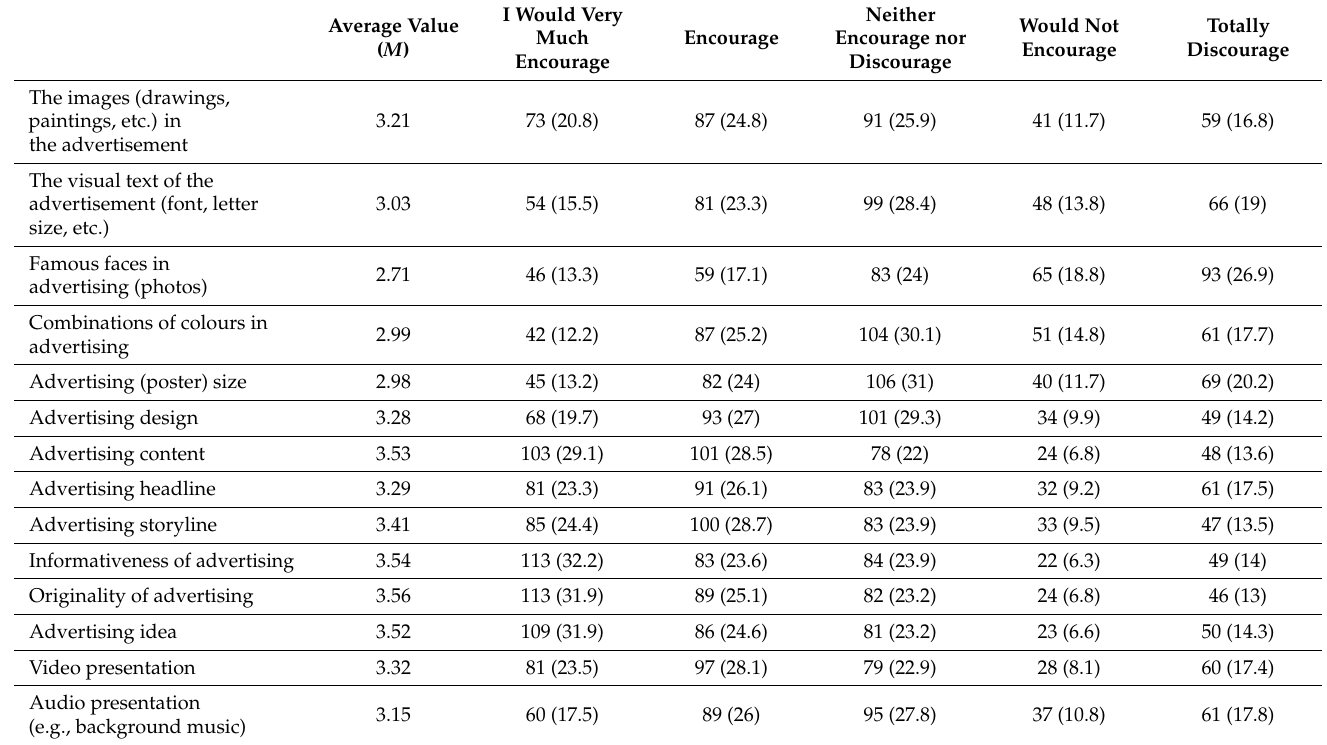
Table 5. Evaluation of elements in advertising that promote sustainable mobility and multimodality. I Would Very Average Value ( M )